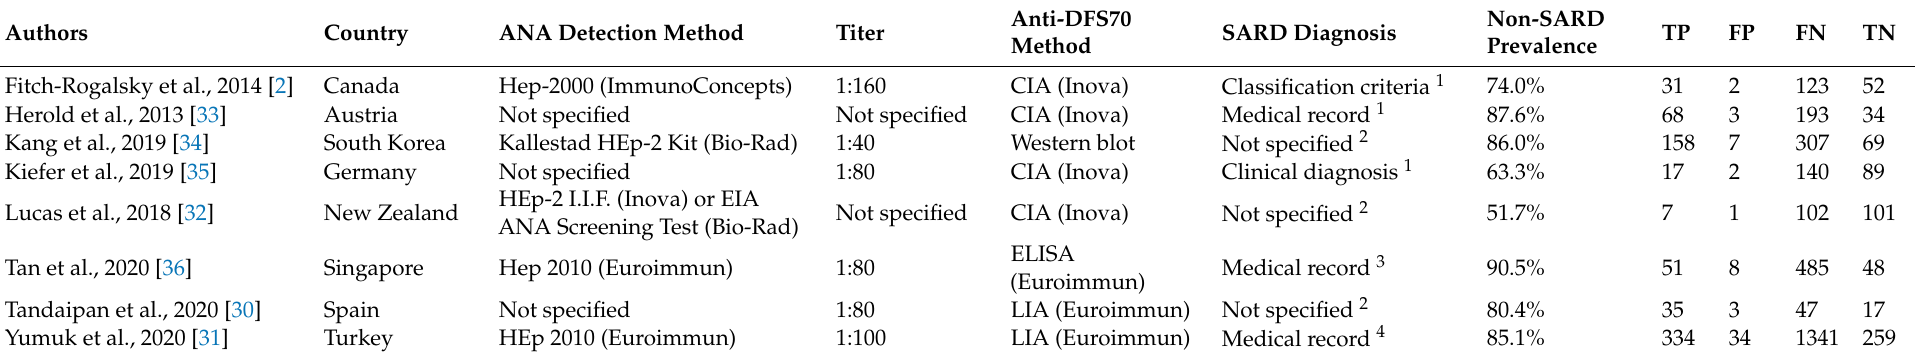
Table 1. Main characteristics of the included